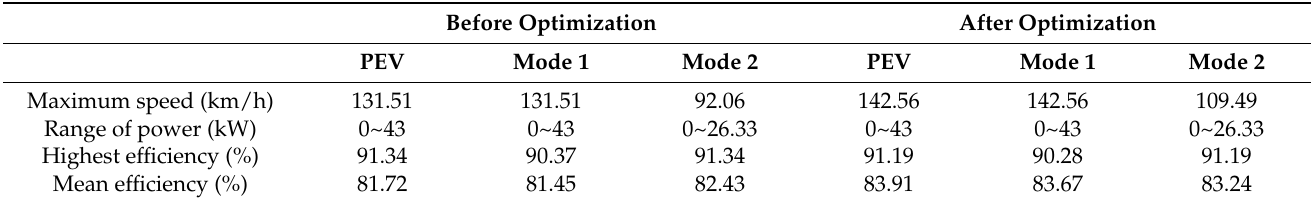
Table 3. Results